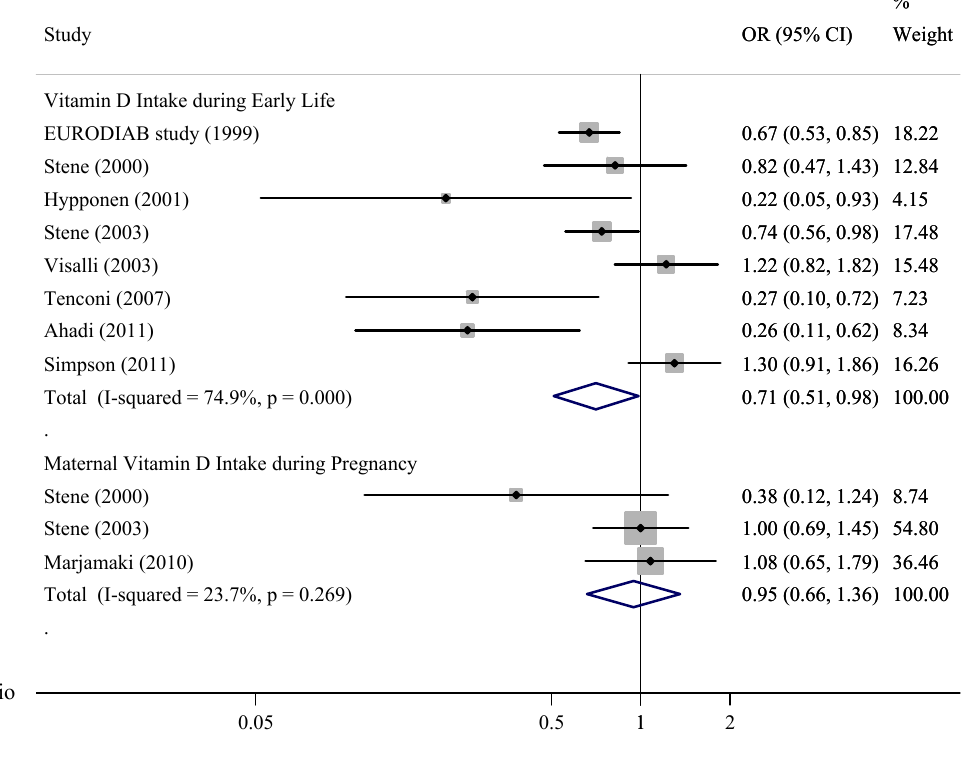
Figure 2. Meta-analysis of observational studies on vitamin D intake and risk of type 1